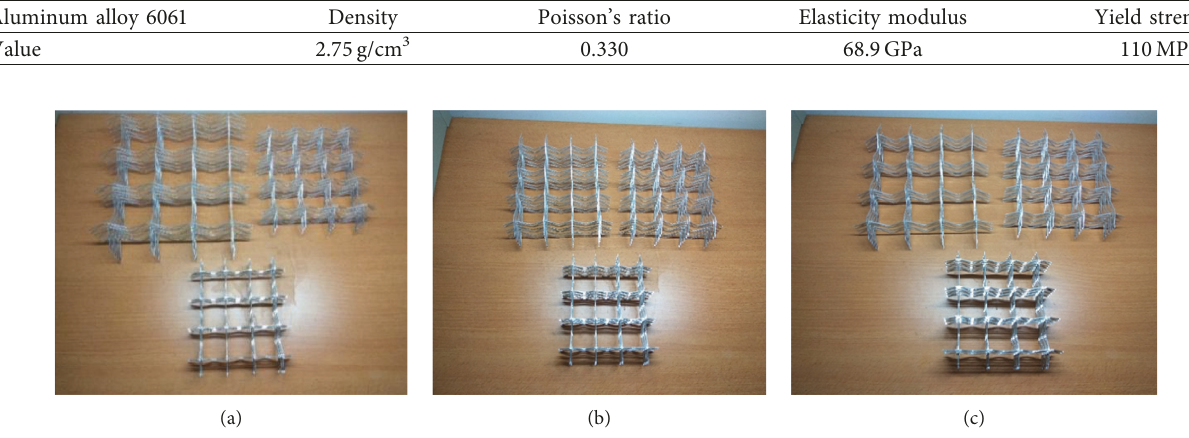
Figure 4: Samples of core material after assembly: samples (a) 1–3, (b) 4–6, and (c) 7–9.